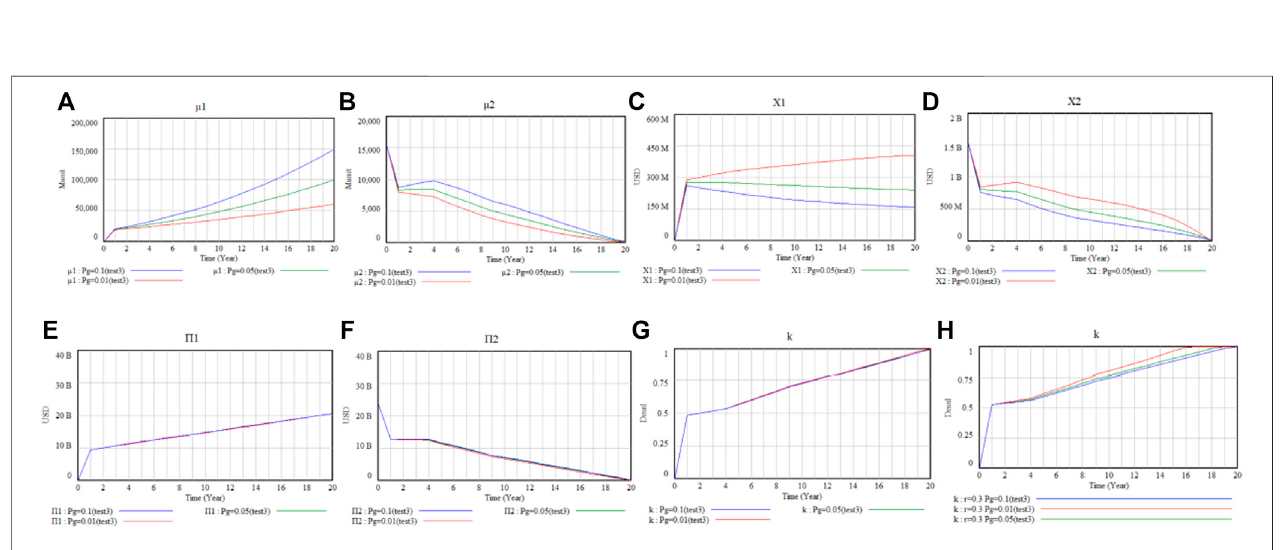
Frontiers in Energy Research |